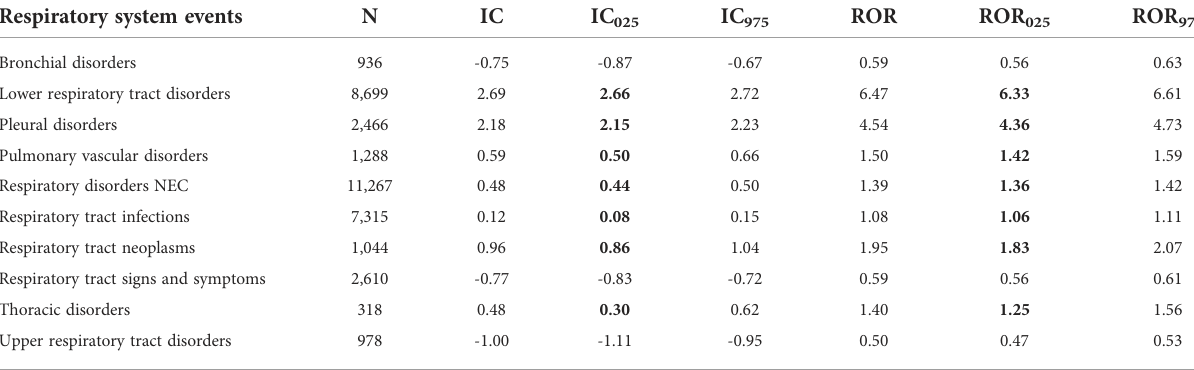
TABLE 3 Results of the disproportionality analysis for class-speci fi c respiratory system AEs associated with ICIs.